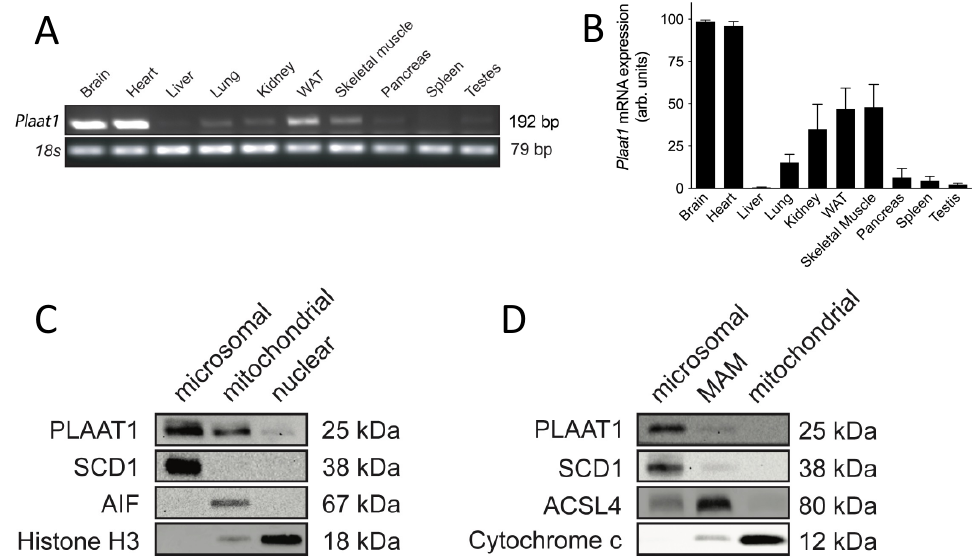
Figure 1. PLAAT1 expression and subcellular localization. Plaat1 gene expression was detected at highest levels in brain, heart, white adipose tissue (WAT), and skeletal muscle, but was also visualized ( A ) and found by density analysis of bands ( B ) to be present in other tissues at lower levels. Data are means ± S.E.M., n = 3–6. Subcellular localization of PLAAT1 was investigated by immunoblotting microsomal, mitochondrial, and nuclear fractions produced by differential centrifugation of whole mouse brains for PLAAT1, or for markers of fractional purity including SCD1 as a marker of the endoplasmic reticulum (ER), AIF as a mitochondria-specific marker, and histone H3 as a nuclear marker ( C ). Alternately, mouse brains were separated to derive ER (microsomal), mitochondria- associated ER matrix (MAM), and mitochondrial fractions for detection of PLAAT1 or markers of fractional purity (i.e., SCD1 (ER), ACSL4 (MAM), and cytochrome c (mitochondria)) ( n = 3) ( D